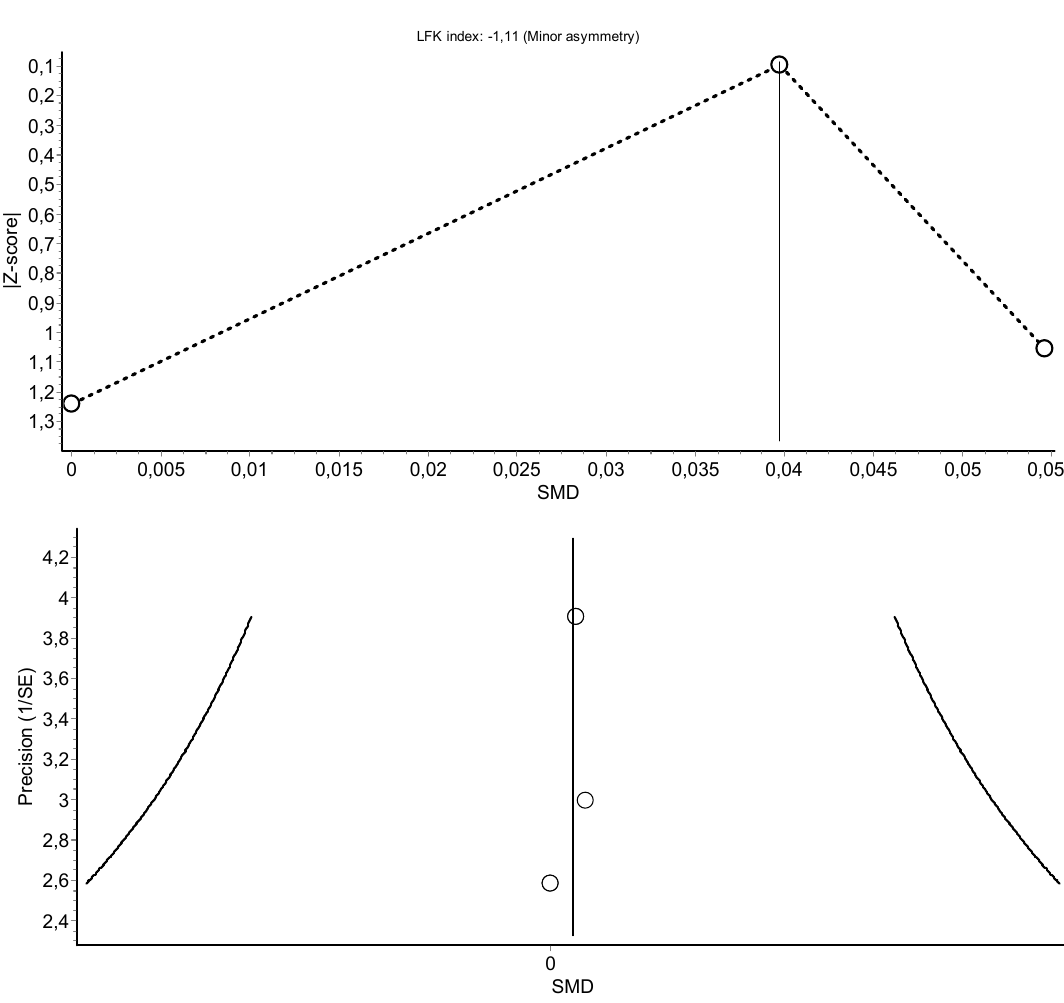
Figure A11. Synthesis funnel and Doi plot (LFK index) for muscle mass.